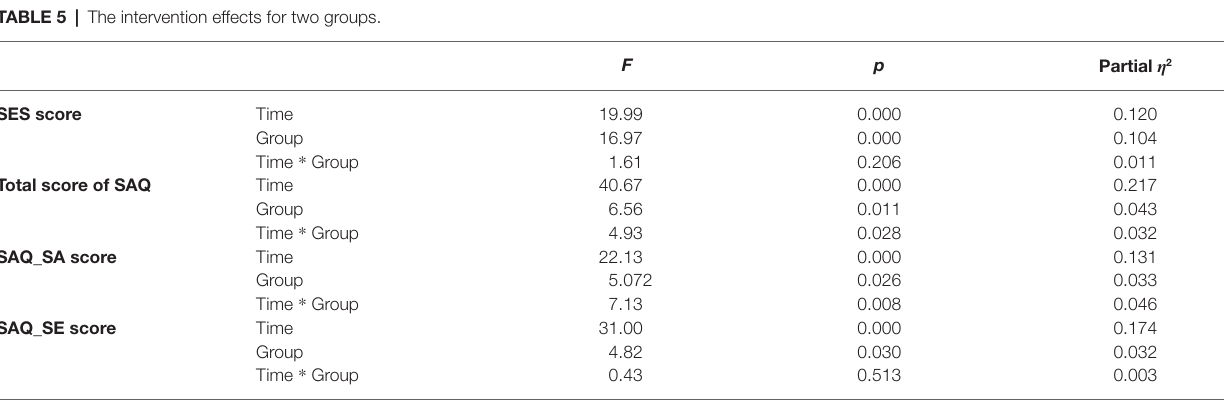
TABLE 5 | The intervention effects for two